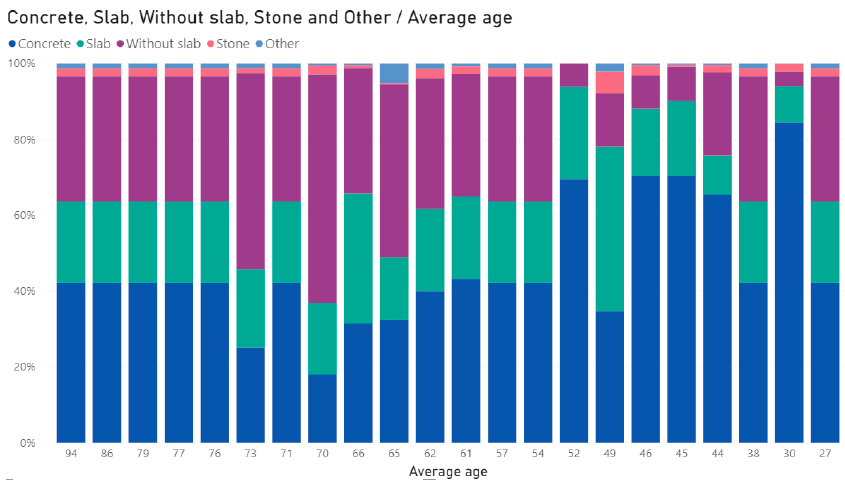
Figure 9. Structure types by building’s age.